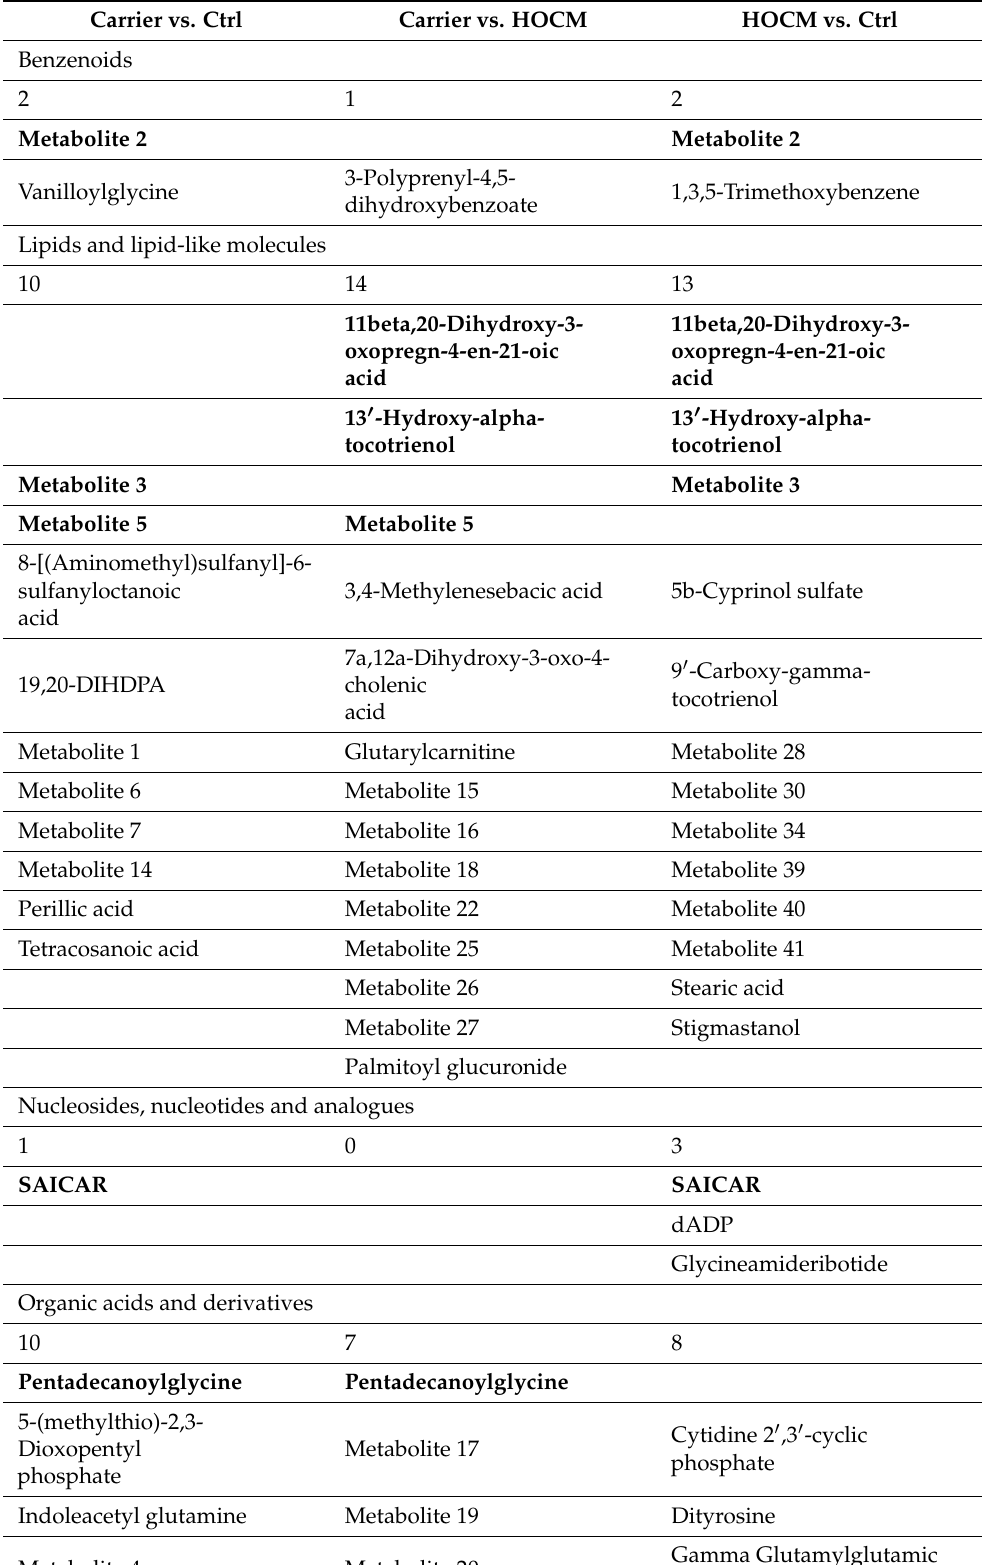
Table 2. Top 30 most important metabolites of the three pairwise comparisons categorized based on their chemical taxonomy super class 2